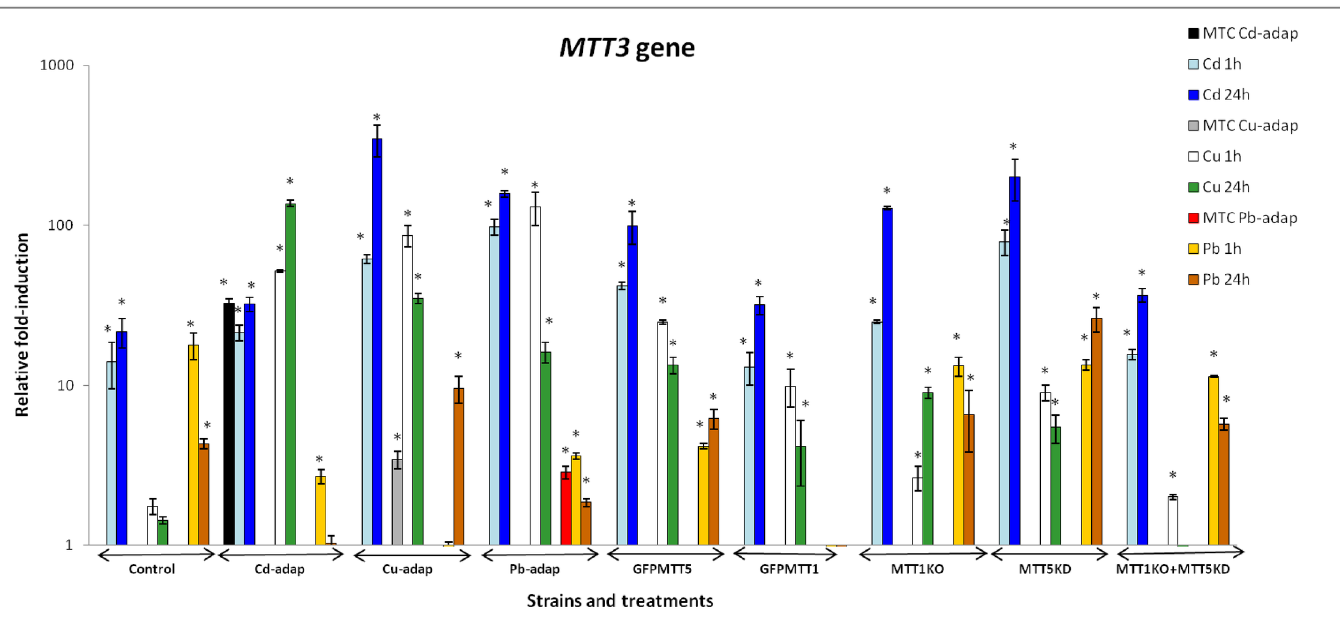
Fig 3. Comparison of relative fold-induction of MTT3 in different T . thermophila strains. MTC: maximum tolerated concentration (115 μ M Cd 2+ , 4 mM Cu 2+ or 5.5 mM Pb 2+ ). β -actinwas used as the normalizergene. Each histogrambar represents an averagevalue ± standarddeviation(see S3 Table) from two or three independentexperiments. Relativeinductionvalues are representedin a logarithmic scale. Asterisks indicatesignificantdifferencesfrom the control with p (cid:20)